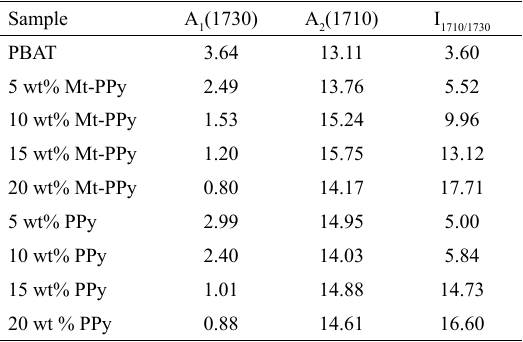
) and free C=O (A ). 1710 1730)